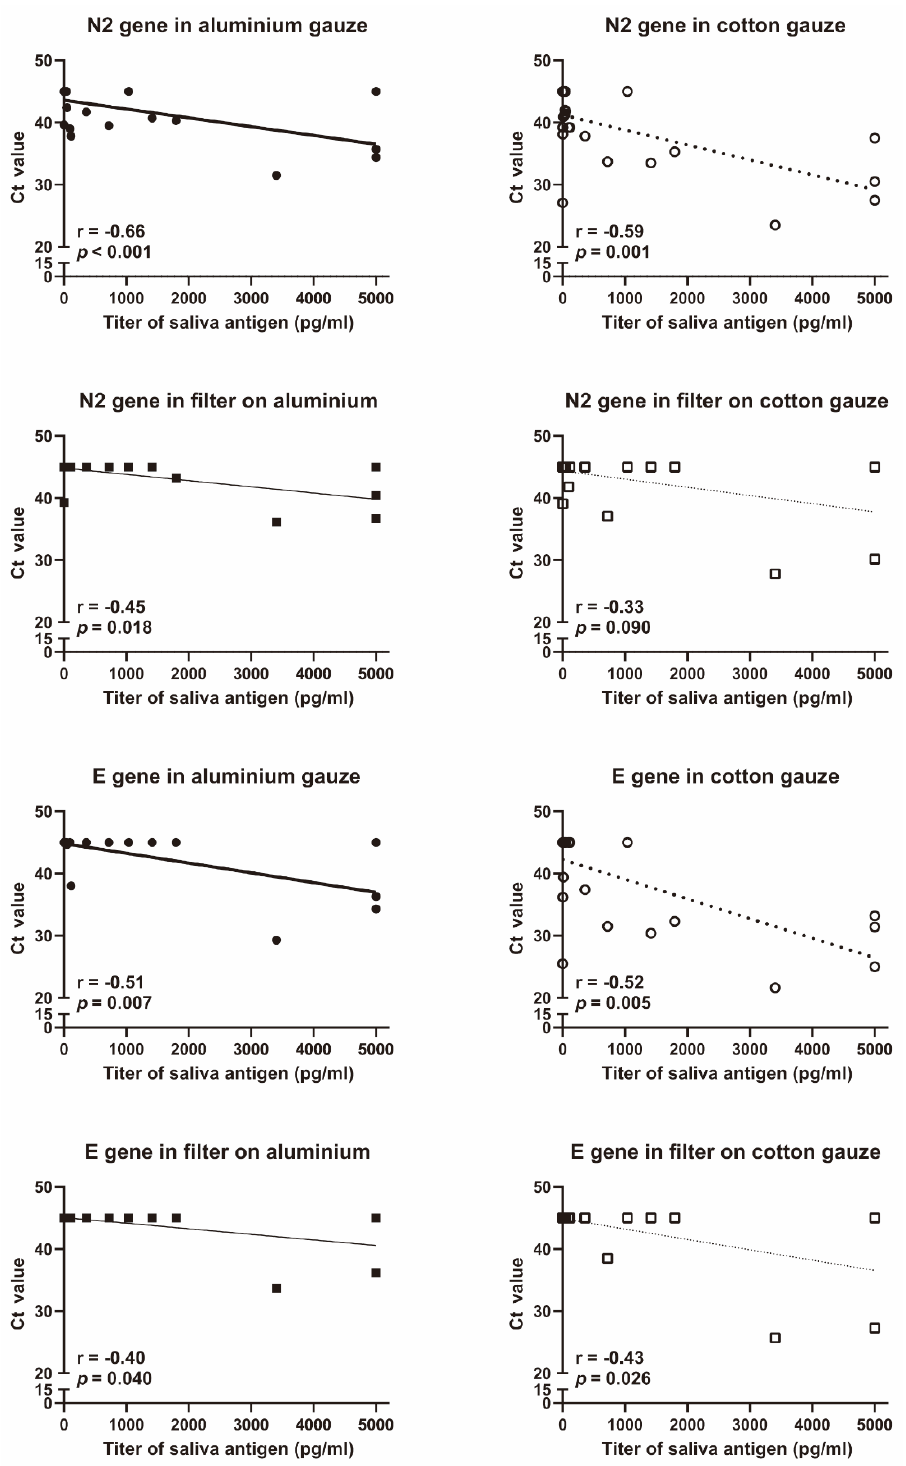
Figure 2. Correlation between saliva antigen and N2 or E genes of SARS-CoV-2 in gauzes and filters. The N2 and E genes of SARS-CoV-2 were analysed using Xpert ® Xpress SARS-CoV-2 (Cepheid, Sunnyvale, CA, USA). Salivary SARS-CoV-2 antigen was assessed using the Lumipulse G SARS-CoV-2 Ag (Fujirebio, Tokyo, Japan). The r and p values were evaluated using the Spearman rank correlation test.